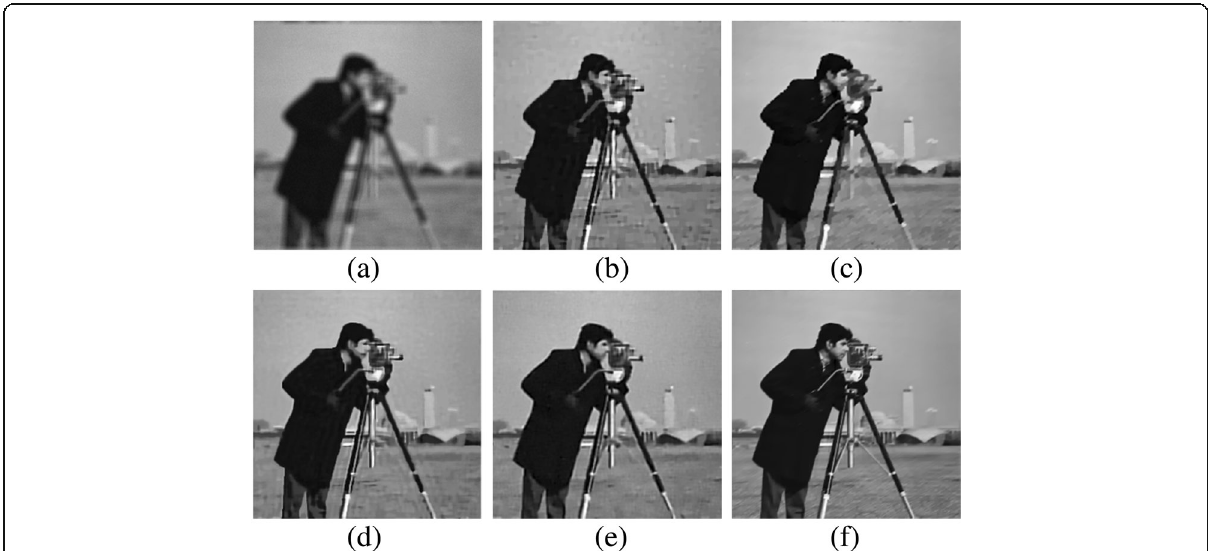
(PSNR = 22.45, t = 3.7 s). c GOS_TV [15] (PSNR = 23.09, t = 5.7 s). d The local/nonlocal TV [26] (PSNR = 24.57, t = 10.5 s). e The nonlocal